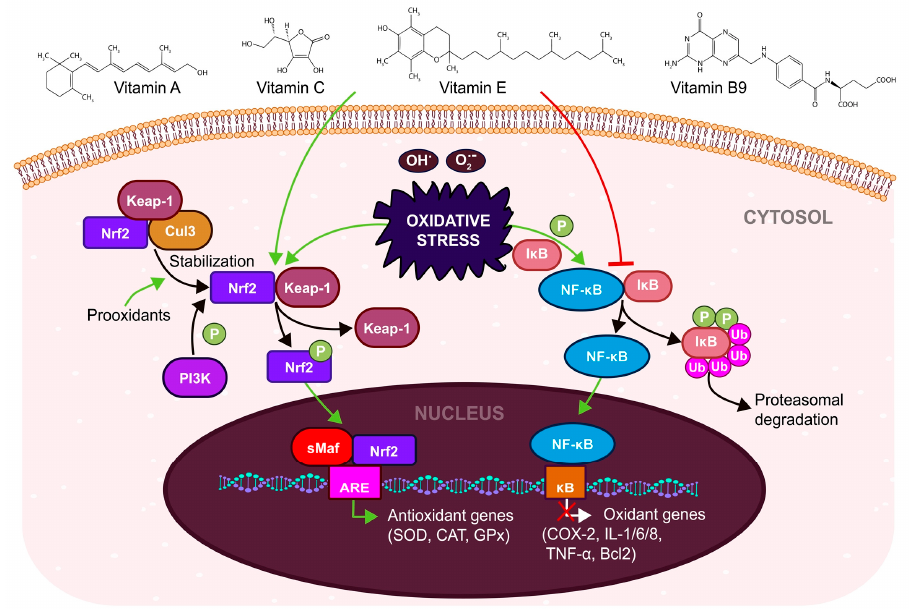
Figure 4. A summary of vitamin A-C-E-B9 action in the activation (green arrows) of Nrf2 signaling and suppression (red line) of NF- κ B signaling. (Nrf2—Nuclear factor erythroid 2–related factor 2,